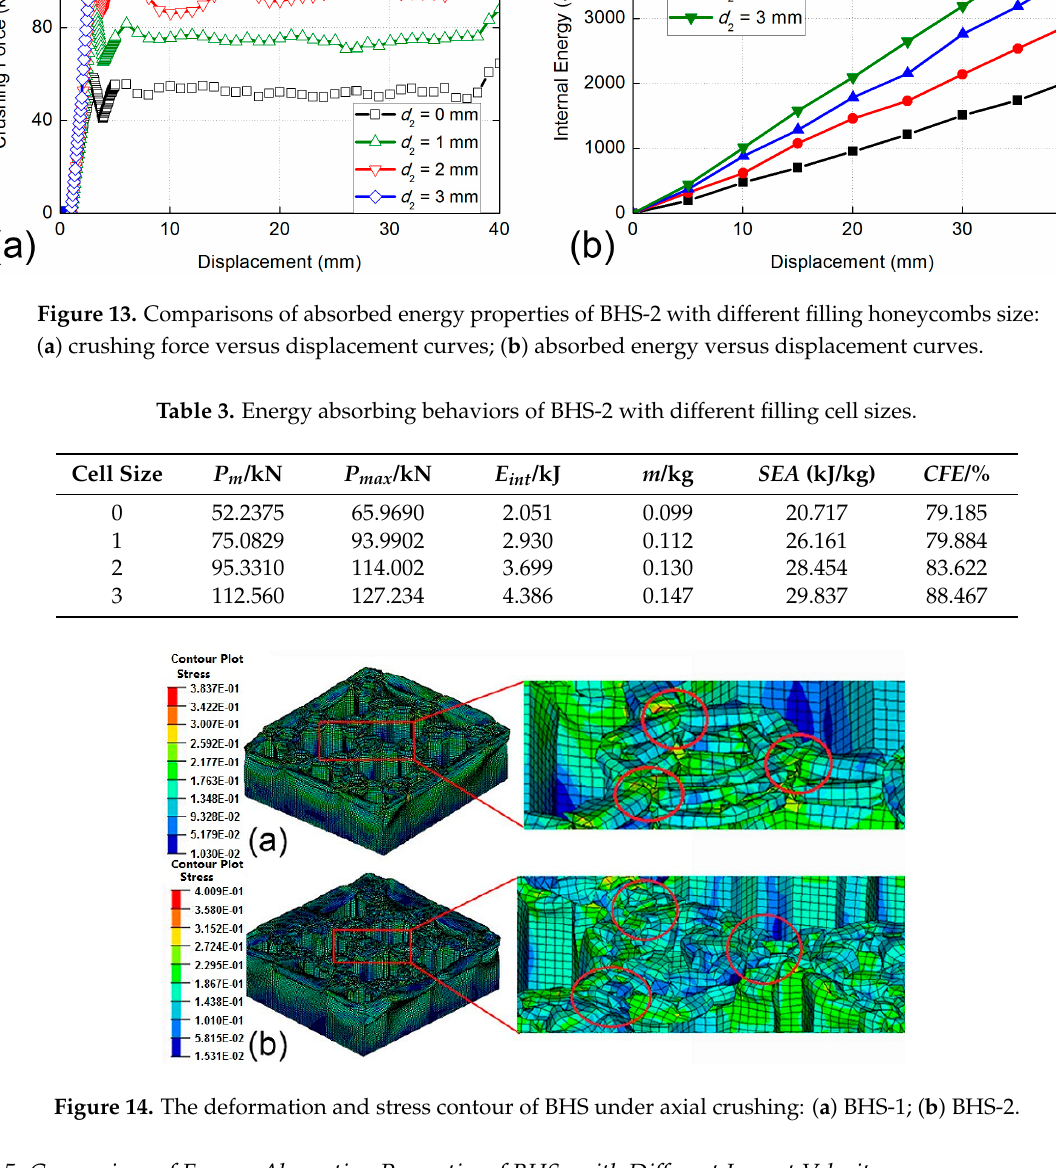
Figure 14. The deformation and stress contour of BHS under axial crushing: ( a ) BHS-1; ( b ) BHS-2.